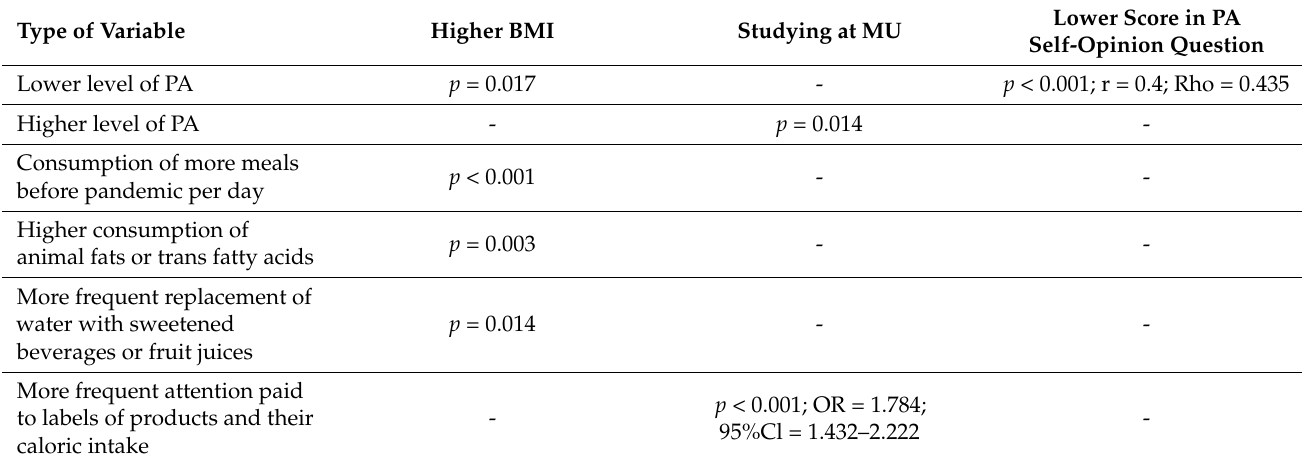
Figure 4. Answers to self-opinion question about dietary habits expressed in number of participants and percentages.